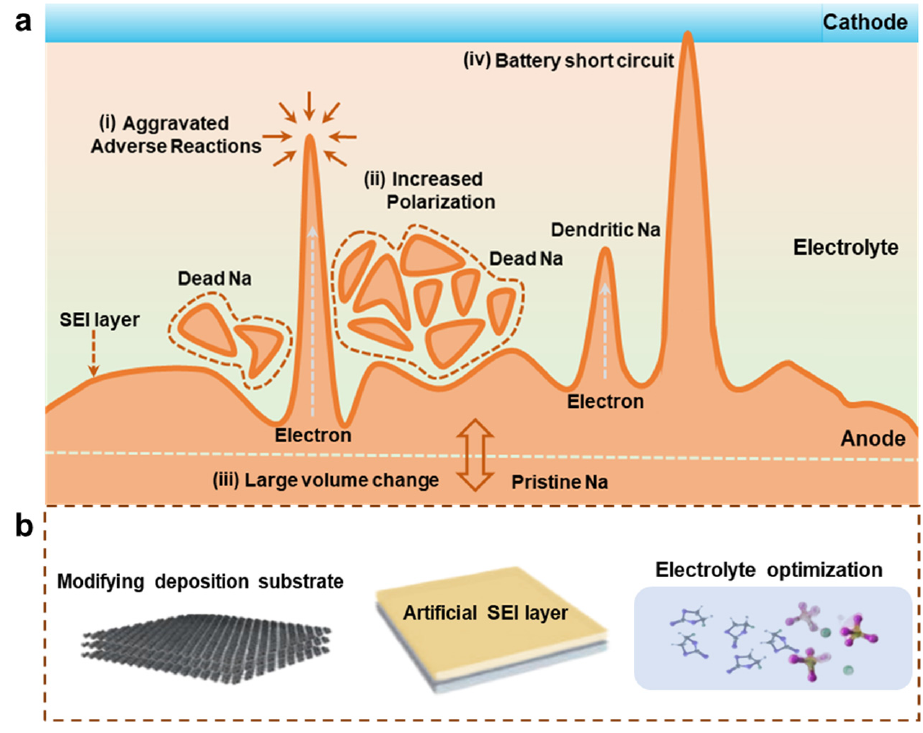
Figure 1. ( a ) Scheme of dilemmas for the Na metal anode. ( b ) Three main strategies to resolve the dilemmas for the Na metal anode.